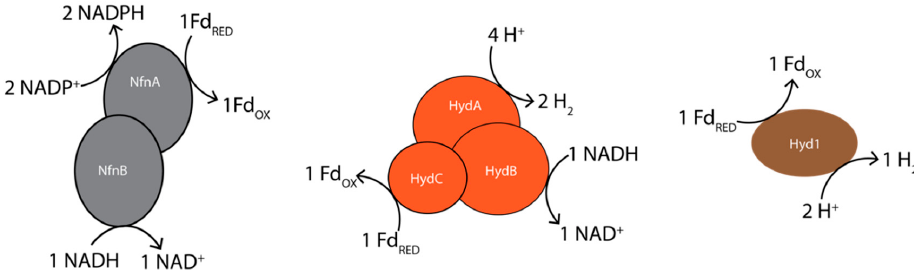
Figure 5. Additional enzymes for redox balancing in MCFA-producing bacteria. NfnAB couples NADH and Fd RED oxidation with NADP + reduction. HydABC relies on electrons from both NADH and Fd RED to reduce protons. A ferredoxin hydrogenase uses only Fd RED for hydrogen